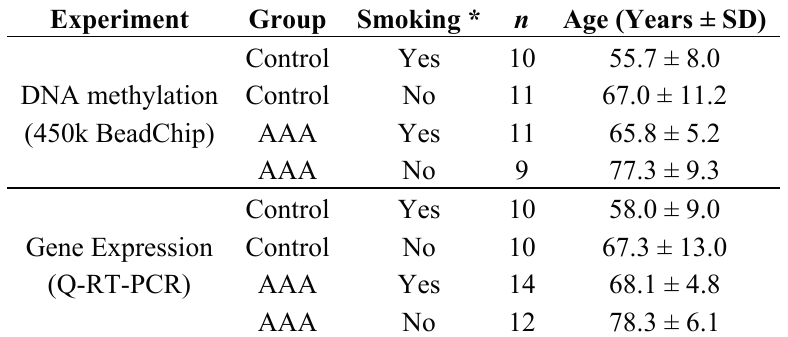
Table 1. Summary of experimental groups used in the microarray-based DNA methylation and RT-PCR-based gene expression